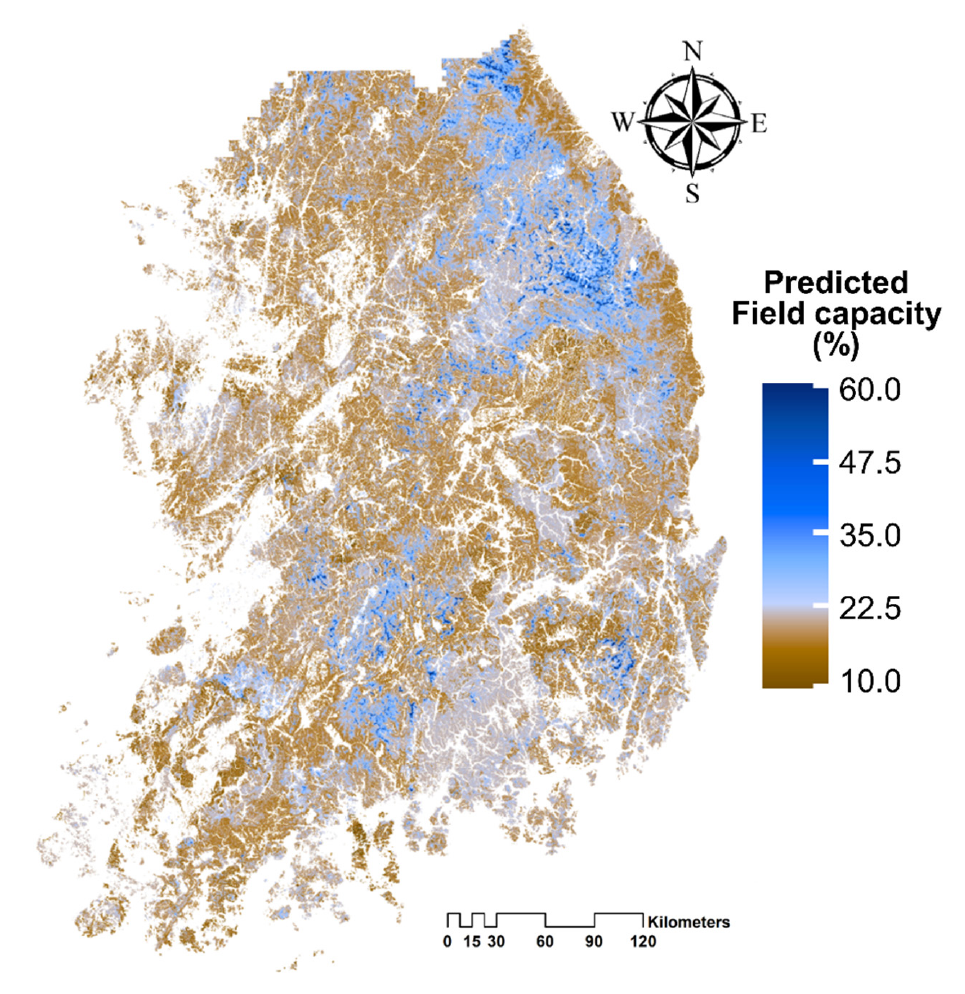
Figure 6. Spatial distribution of predicted forest FCs on a national scale.